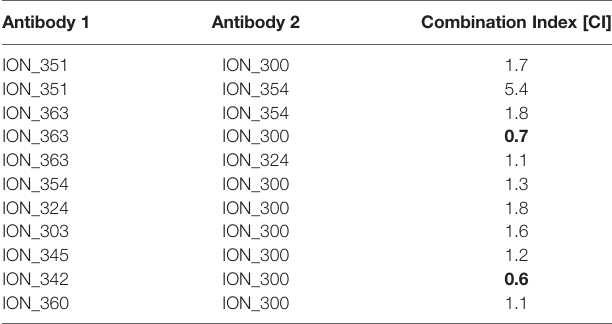
Each antibody in the combinations listed was tested individually or at 1:1 ratio with the pairing antibody in the authentic SARS-CoV-2 neutralization assay. The Combination Index (CI) for each antibody pair was calculated with CompuSyn (28, 32). Based on the recommended cut-off values by CompuSyn, CI values <0.9 indicates synergy (in bold); 0.9<CI<1.1 indicate additive effect; CI>1.1 indicates antagonism. Antibody pair ION_351 and ION_354 from overlapping bins (A and C) was used as negative control for the